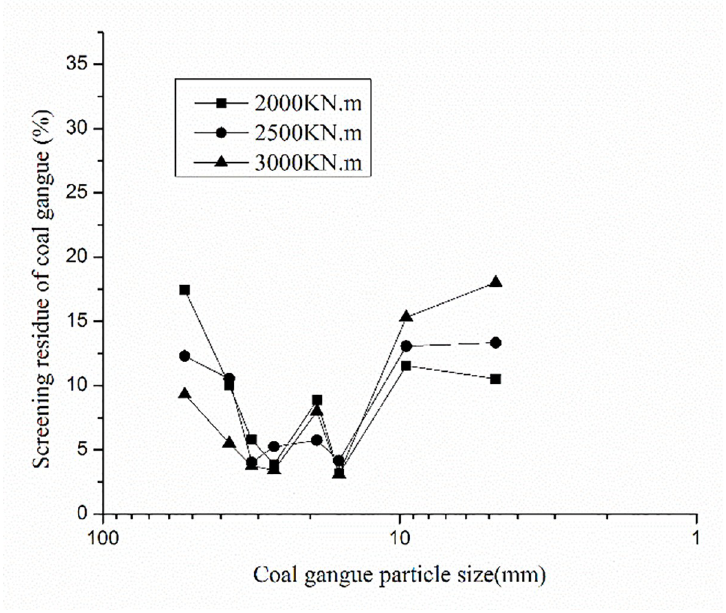
Fig 11. Comparison of residual curve of coal gangue particle sieve points by different tamping energy.